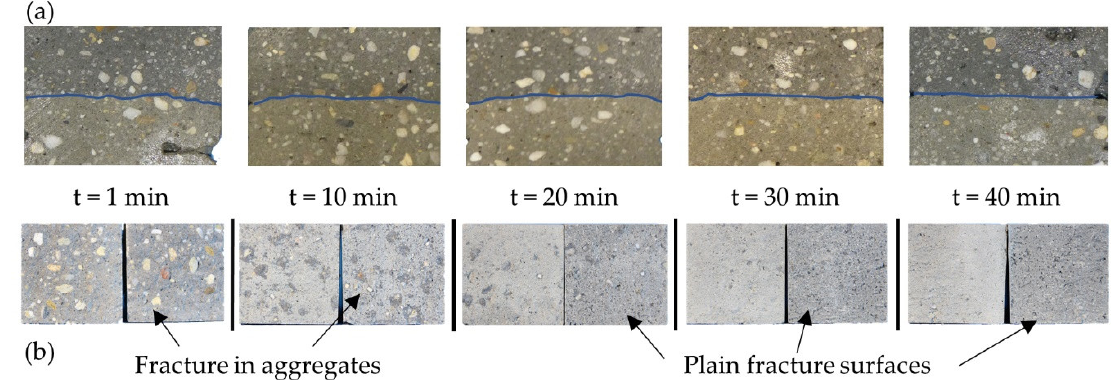
Figure 9. Quality of adhesion with increasing interval time—( a ) undulation of interface region and ( b ) fracture surfaces after 3-point bending test.